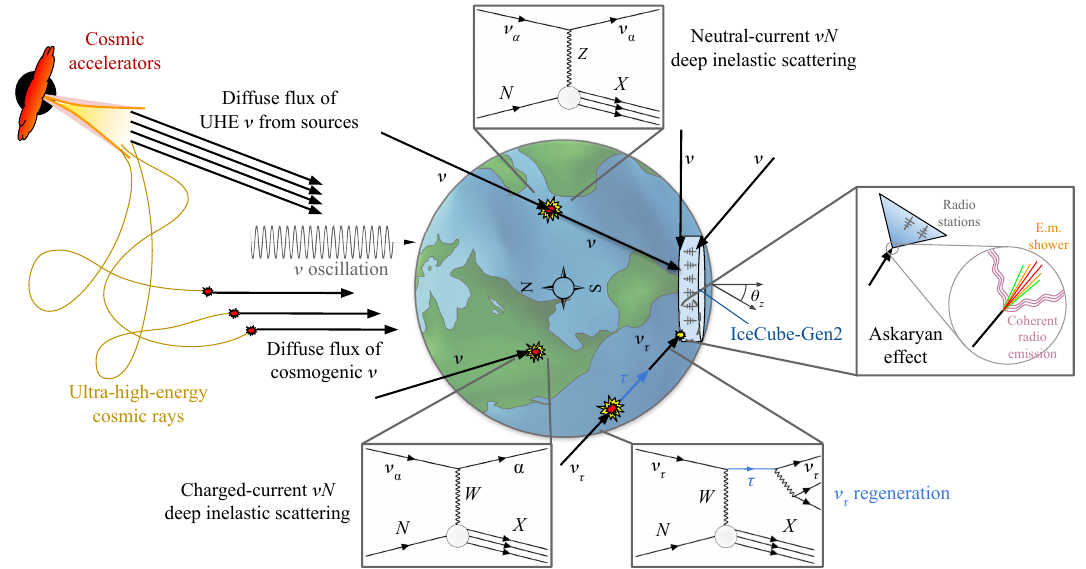
Figure 2 . Overview of the calculation used to forecast ultra-high-energy (UHE) cross-section measurement capabilities. A diffuse, isotropic flux of UHE neutrinos, of energies in excess of 100 PeV, cosmogenic or from astrophysical sources, reaches the Earth. UHE neutrinos propagate through the Earth, across different directions, toward the envisioned IceCube-Gen2 neutrino telescope, located in the South Pole. Inside Earth, neutrinos interact with matter, mainly via neutrino-nucleon ( νN ) deep inelastic scattering. As a result, their flux is attenuated and shifted to lower energies. At IceCube-Gen2, neutrinos interact in the ice and induce particle showers that radiate coherent radio emission that may be detected by antennas buried in the ice. The sensitivity to the νN cross section stems from differences in the distribution of neutrino arrival directions, especially of neutrinos coming to the detector horizontally or near-horizontally. See the main text for